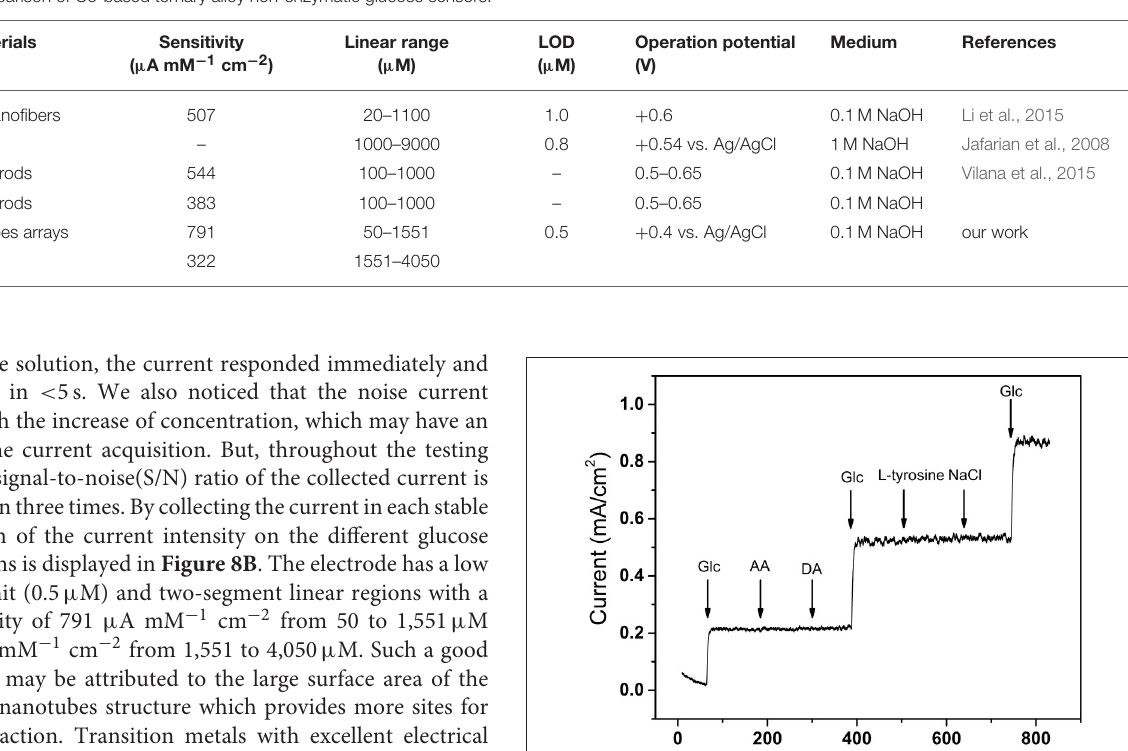
TABLE 1 | Comparison of Co-based ternary alloy non-enzymatic glucose sensors.